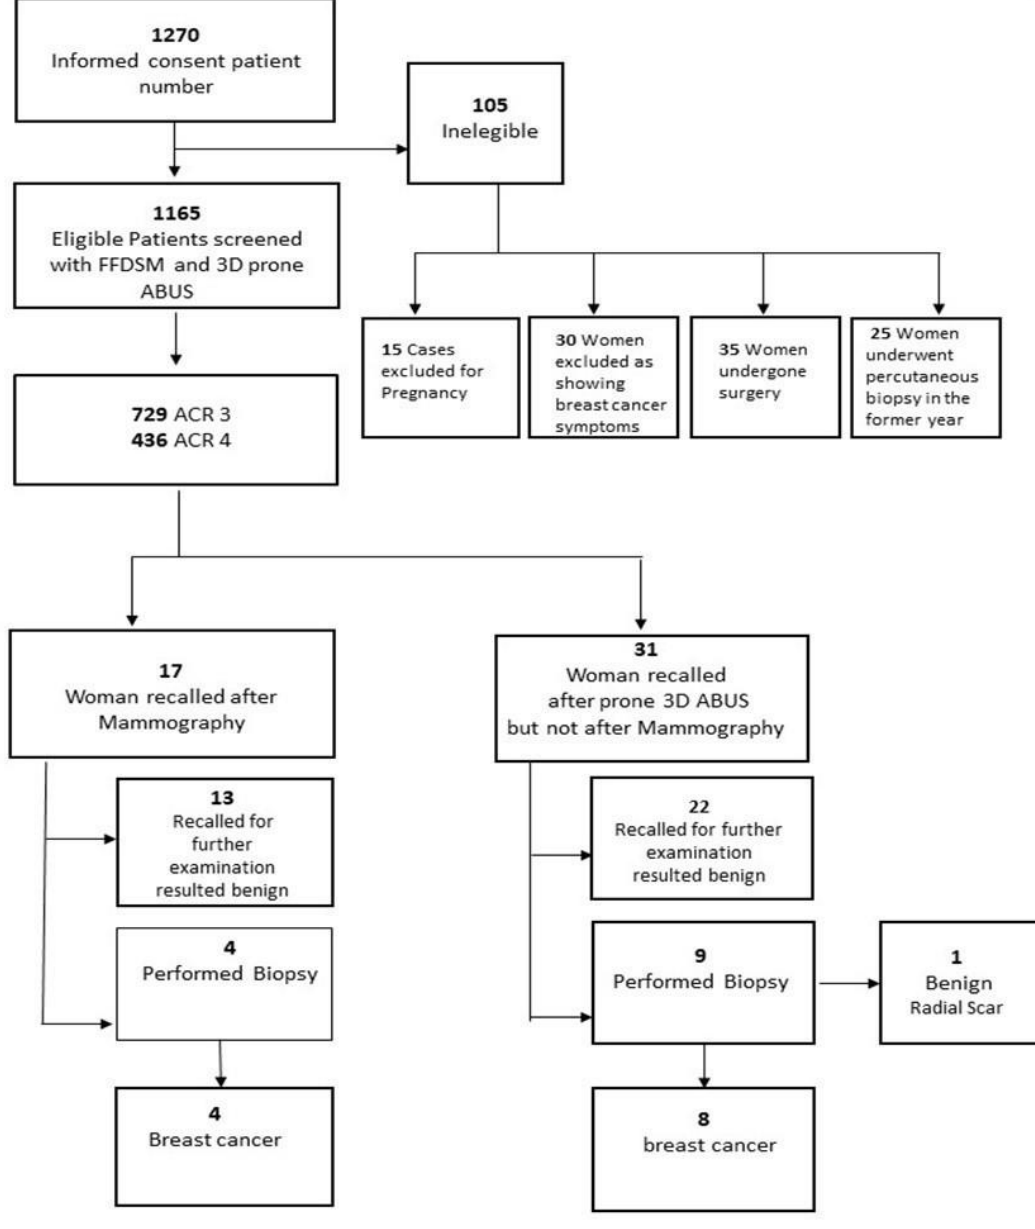
Figure 2. Study overview flowchart. Table 2. Mammography and 3D prone ABUS breast cancer detection.